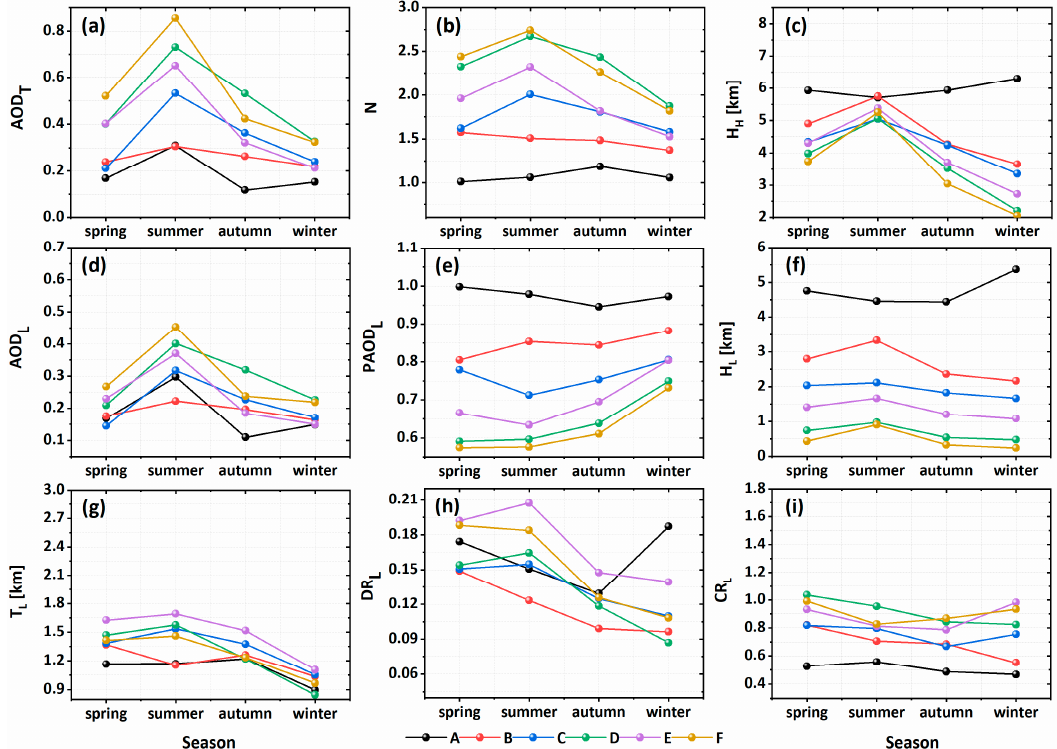
Figure 6. Seasonal variations in the optical characteristics of aerosol layers over Pakistan (A: Gilgit-Baltistan, B: Jammu-Kashmir, C: Khyber-Pakhtunkhwa, D: Punjab, E: Balochistan, F: Sindh) during daytime from 2007 to 2014. ( a ) AOD T , ( b ) AOD L , ( c ) H L , ( d ) H H , ( e ) N, ( f ) T L , ( g ) PAOD L , ( h ) DR L , and ( i ) CR L .